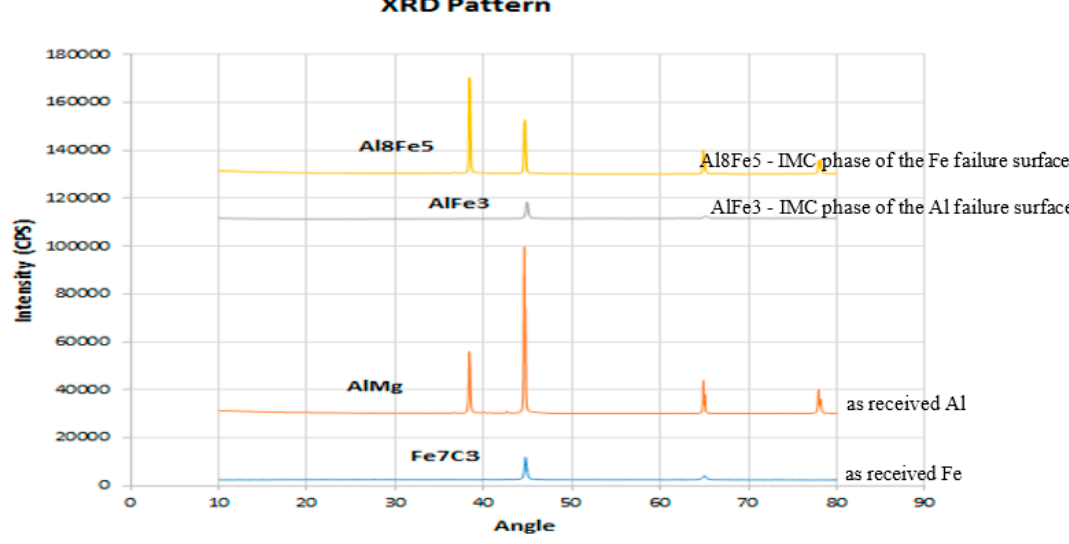
Figure 2. XRD Pattern Analysis of as-received Samples Fe A36, Al 5083, Al and Fe .